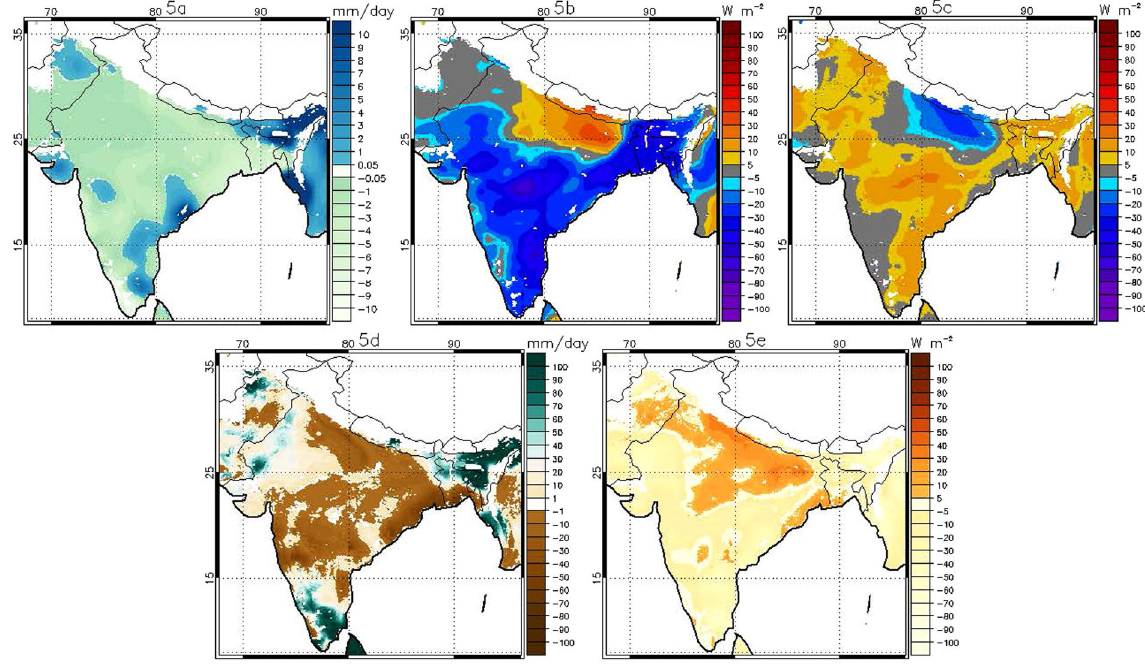
Figure 5. As in Fig. 3, but for the week of June 4 th − 5 th to June 10 th − 11 th in 2015. Data visualizations produced using IDL [8.4] (Exelis Visual Information Solutions, Boulder, Colorado).